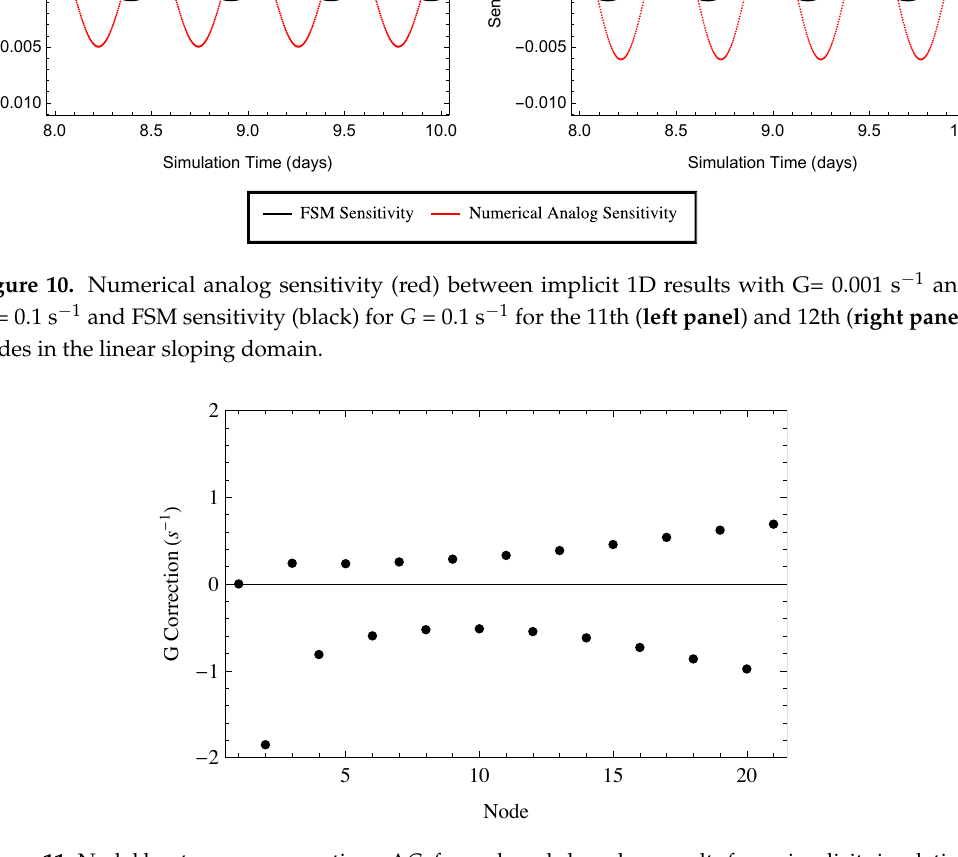
Figure 11. Nodal least-squares corrections, ∆ G , for each node based on results for an implicit simulation with G = 0.1 s − 1 using output from the last two days of the 10.0-day simulation on the linear sloping domain. Observations are from the 2D CG ADCIRC code with G = 0.001 s − 1